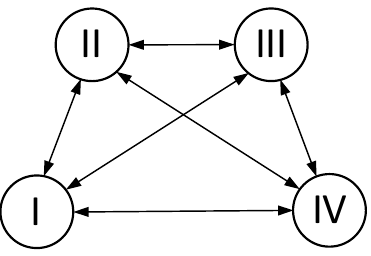
Figure 2. Communication topology with four MASS nodes.